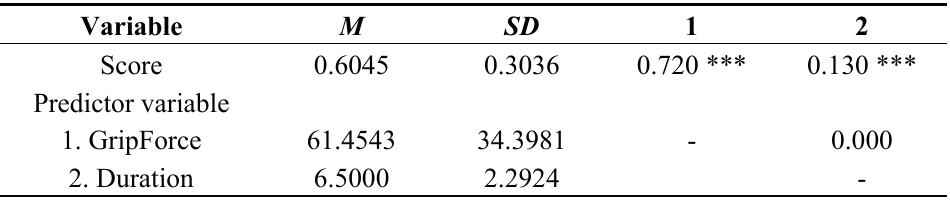
Table 6. Means, standard deviations, and intercorrelations for comfort score and predictor variables ( N = 1080).